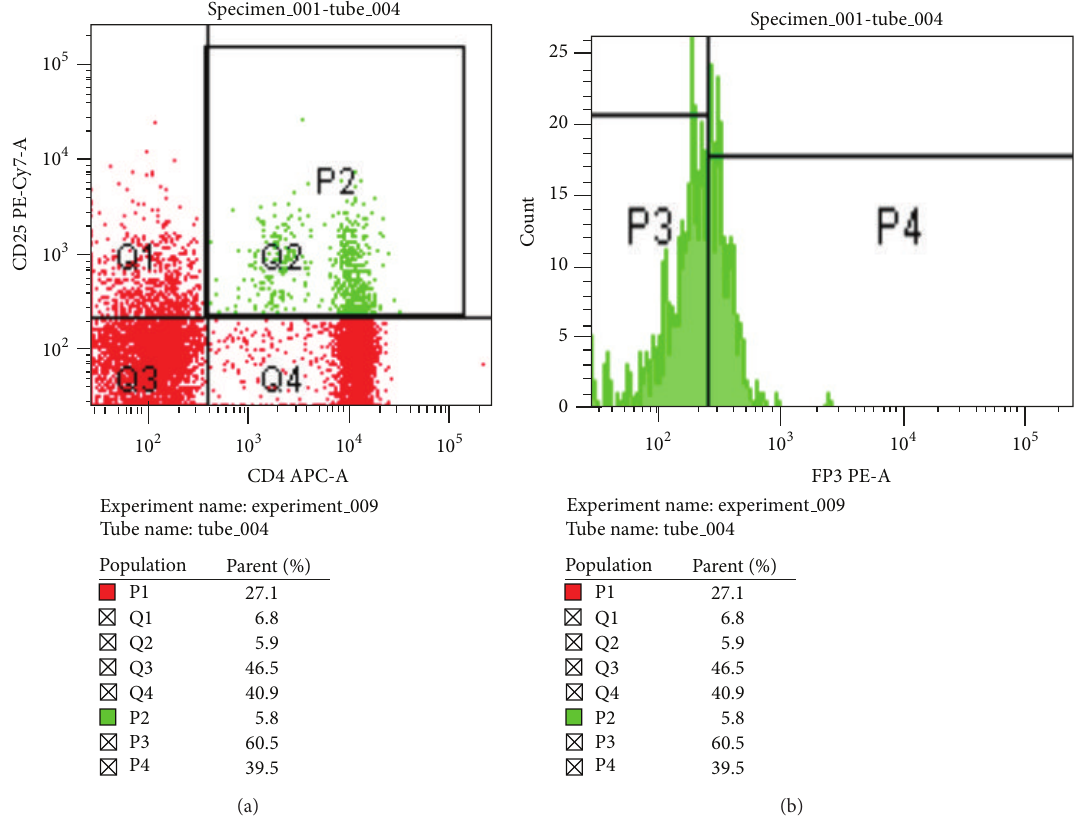
Figure 3: The expression level of CD4 + CD25 + and FOXP3 was examined by flow cytometry in control group. (a) Representation plots of CD4 + CD25 + cells (b) and FOXP3 expression in control group.